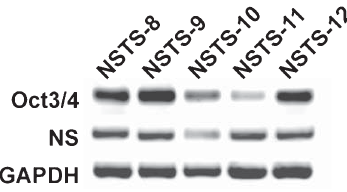
Fig.6. RT-PCRanalysisofstemnessmarkersinrhabdomyosarcoma cell lines. Expression of Oct3/4 and nucleostemin was analyzed in all five of these cell lines; GAPDH served as a